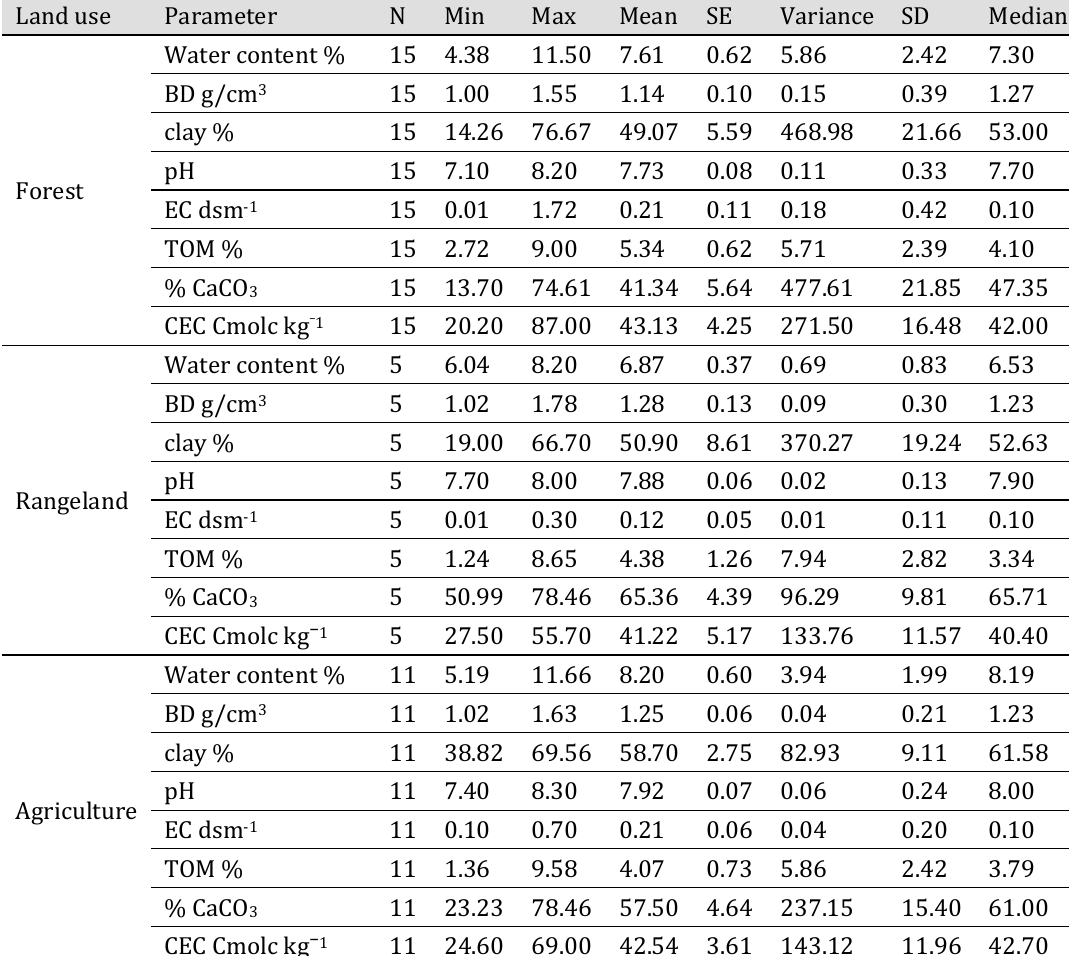
Table 1. the analysis of the physicochemical characteristic of different soil types